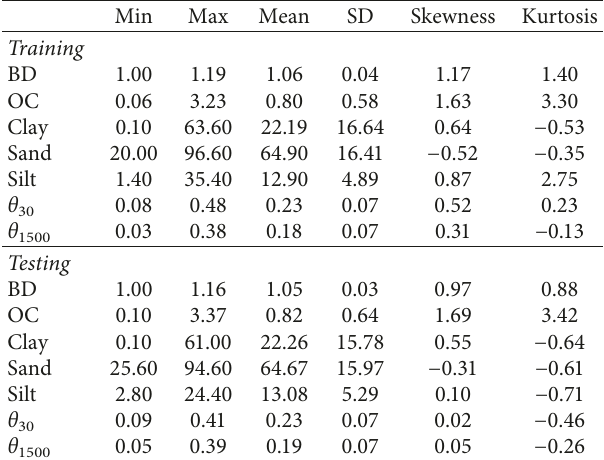
Table 2: Descriptive statistics of training and testing datasets.